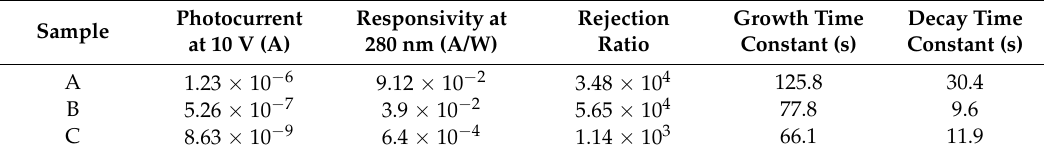
Figure 5. Responsivity of GaZTO photodetectors with different oxygen flow ratios. Table 3. Photocurrent, responsivity, rejection ratio, rise time, and fall time of the GaZTO photodetectors with different oxygen flow